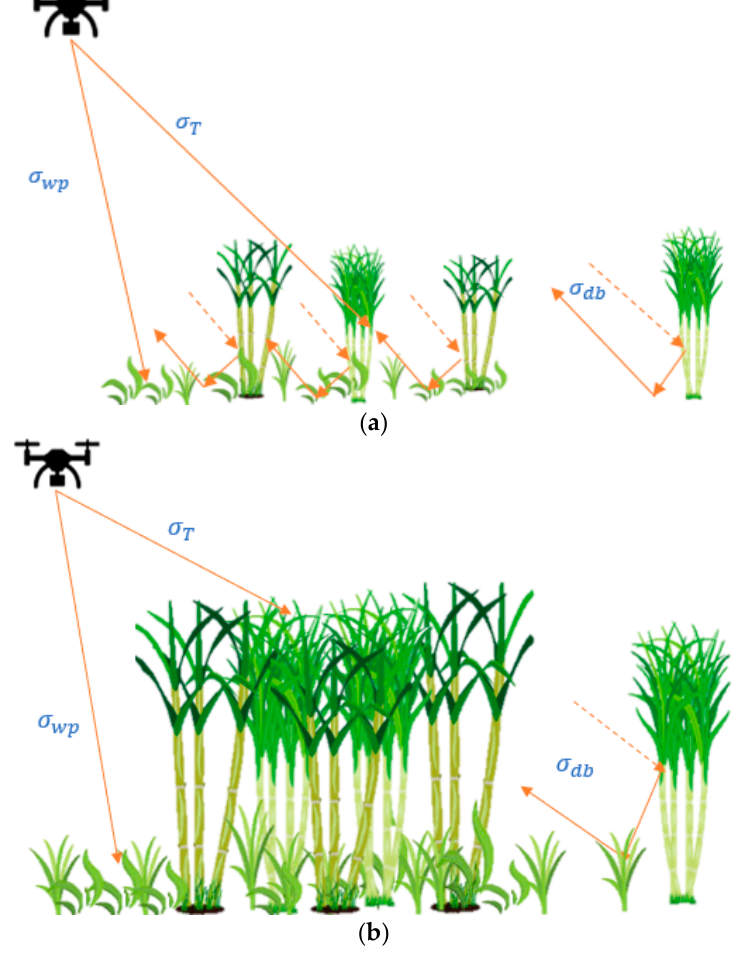
Figure 6. Representation of reflectivity in the corn crop at different growth stages. ( a ) Early stage growth. ( b ) Late-stage growth.